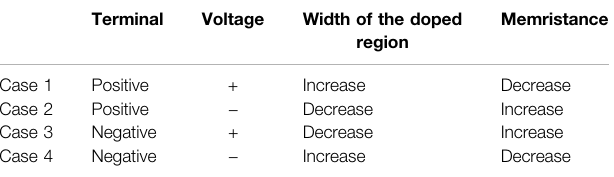
TABLE 1 | In fl uence of input direction and voltage polarity on memristance.